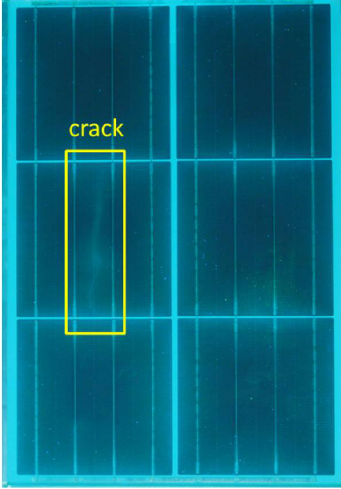
Figure 4. UV-F image of test module no. 1-14 after 2000 h DH showing a cell crack.